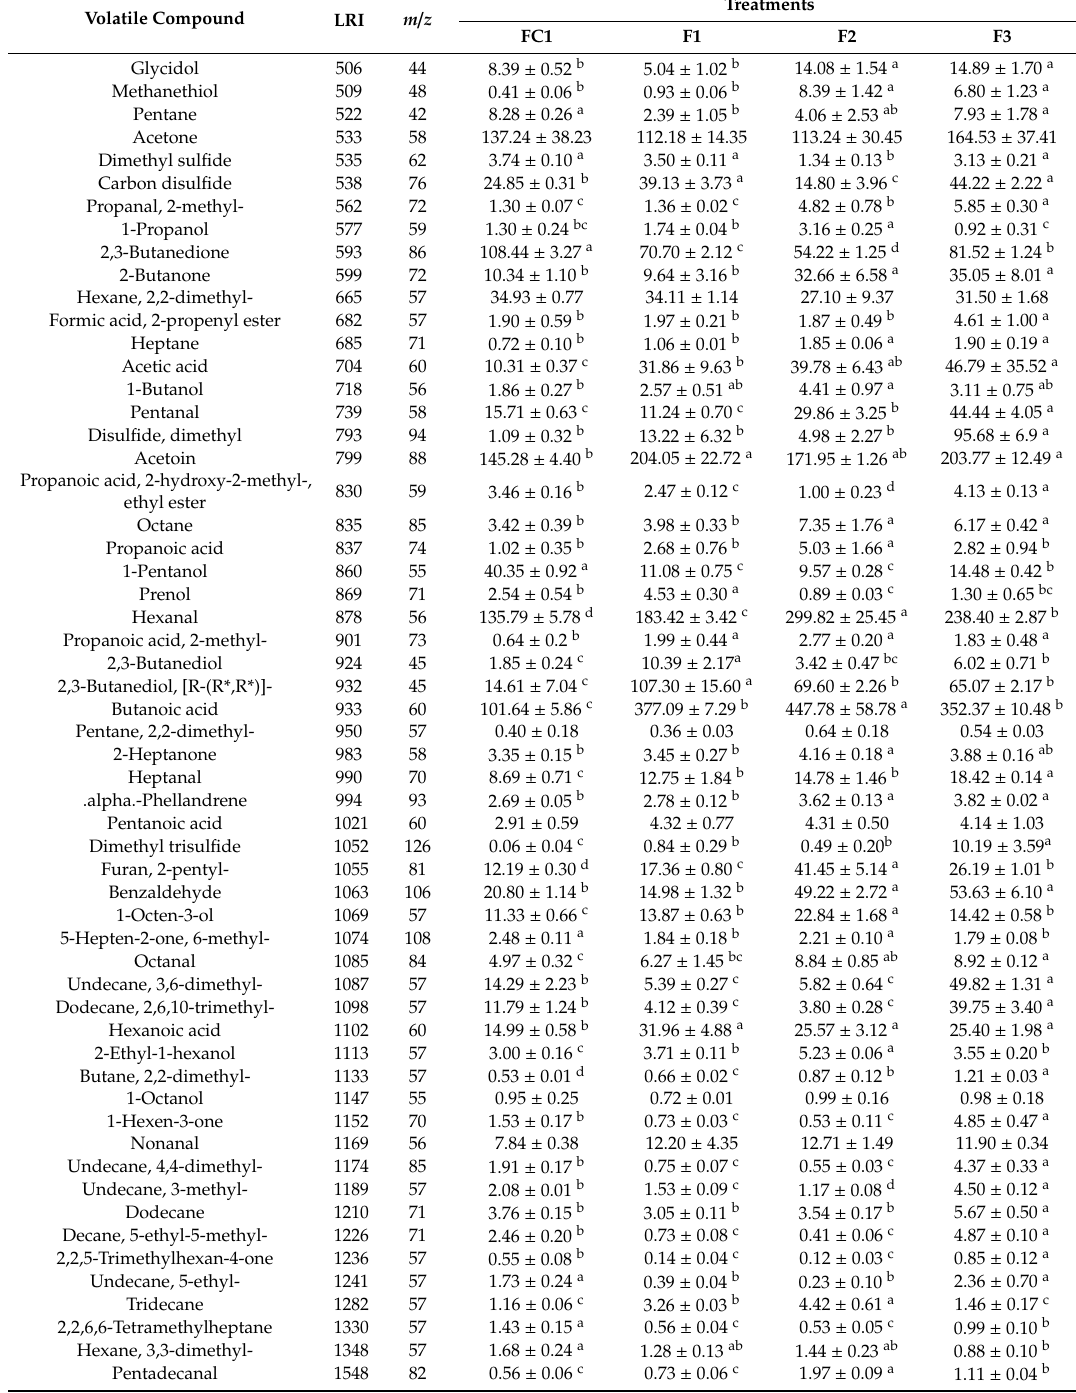
Table 4. Volatile compounds (expressed as area units (AU) of quantifier ion × 10 4 / g) of salted meat (0 day of